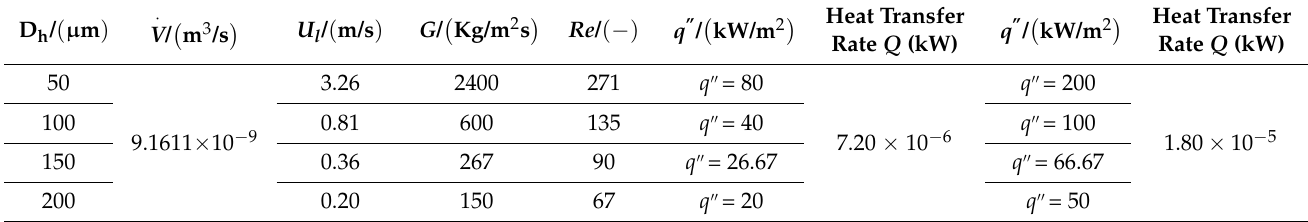
Table 4. Operating conditions of the